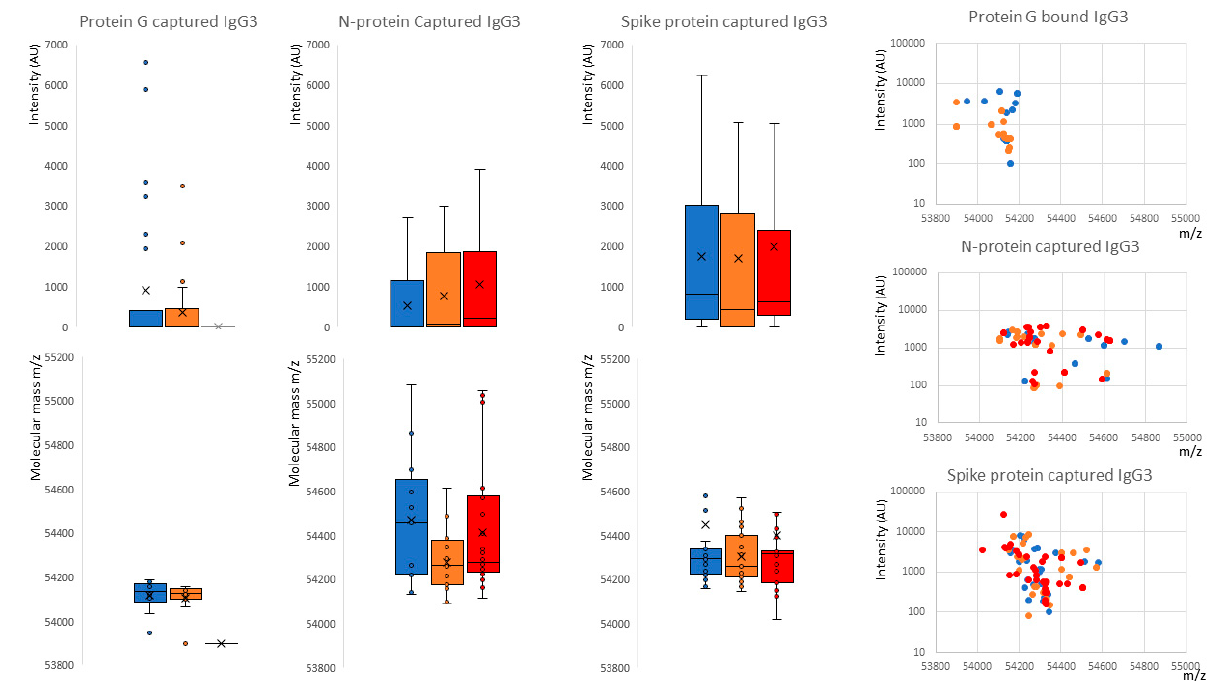
Figure 6. Distribution of intensity for captured and eluted IgG3 heavy chains (IgG3 Hc) and the relative peak molecular masses bound and separated into sample groups. The dot plots to the right are intensity versus molecular mass for individual samples. Blue represents data from SARS-CoV- 2 sero-negative HCWs, orange from SARS-CoV-2 sero-positive HCWs having recovered from mild symptoms and red sample data from convalescent patients recovering from COVID-19 ARDS. The non-parametric Kruskal − Wallis statistical test was carried out to test differences between study co- horts; the p values (alpha: 0.05) were as follows: protein G capture intensity p = 0.61, molecular weight p = 0.006; protein N capture intensity p = 0.067, molecular weight p = 0.19; protein S capture intensity p = 0.75, molecular weight p = 0.97.